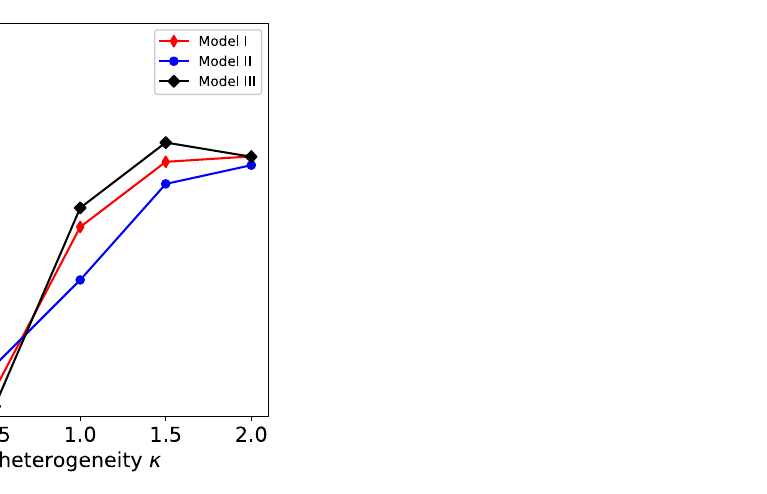
Figure 12. Average path-wise accuracy A (calculated over 20 different pseudo-random loading paths) as a function of the heterogeneity κ . The performance of the classifications in models I, II and III are